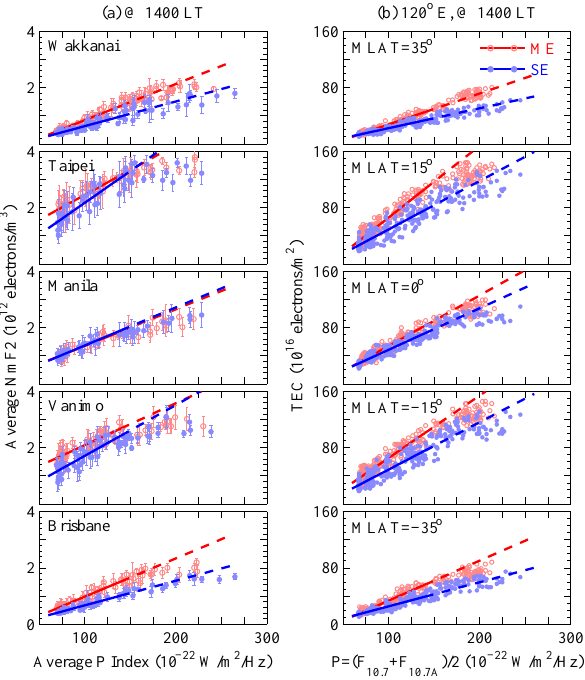
Fig. 2. The variations of equatorial (a) Nm F2 in the East Asia/Australia sector and (b) TEC at 120 ◦ E with the solar proxy P = (F 10 . 7 + F 10 . 7 A ) /2. Circles and dots show observations and er- ror bars show standard deviations, lines are the linear regression fits for the observations at the solar activity level of P < 140.